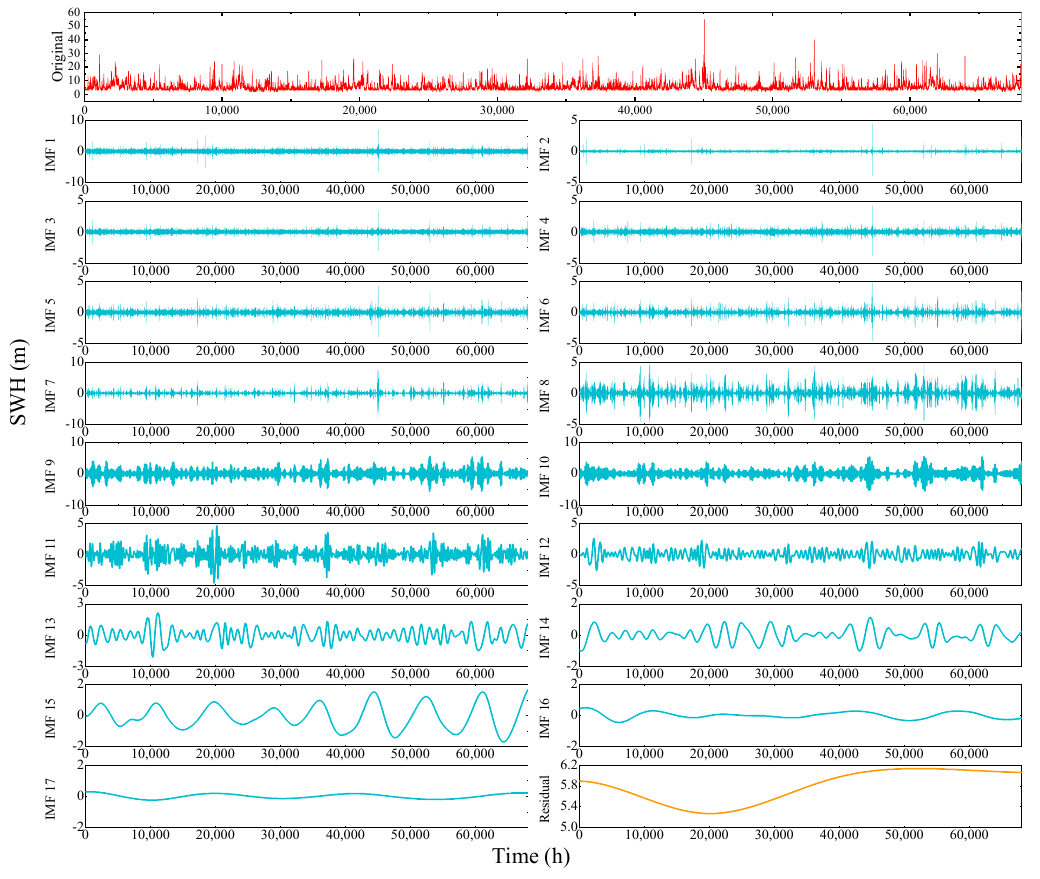
Figure 8. Comparison of ShiDao effective data in the time domain for the IMFs component of SWH sequence by EMD algorithm.